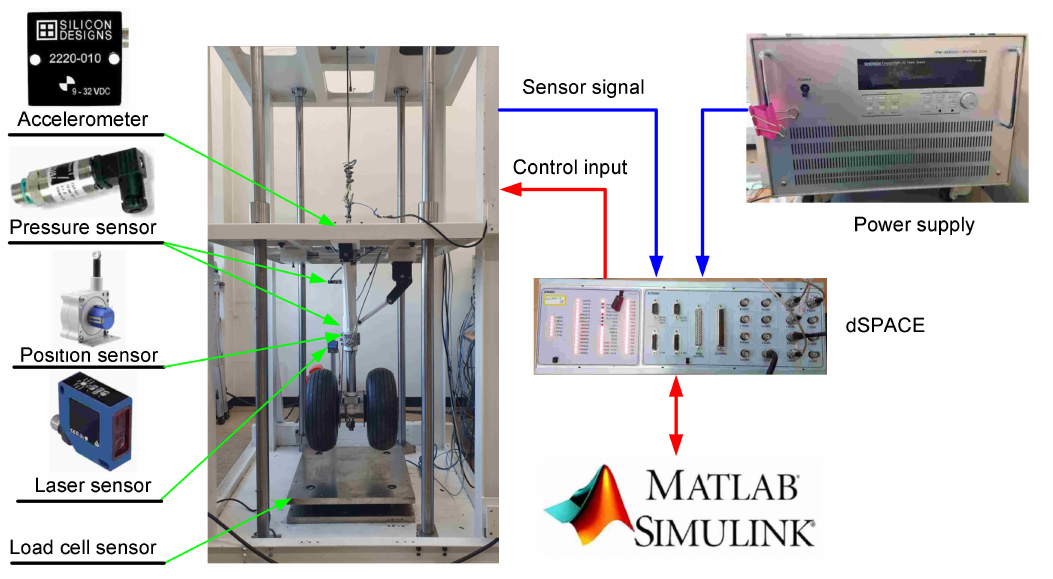
Figure 2. Sensors and signal processing units of the drop test